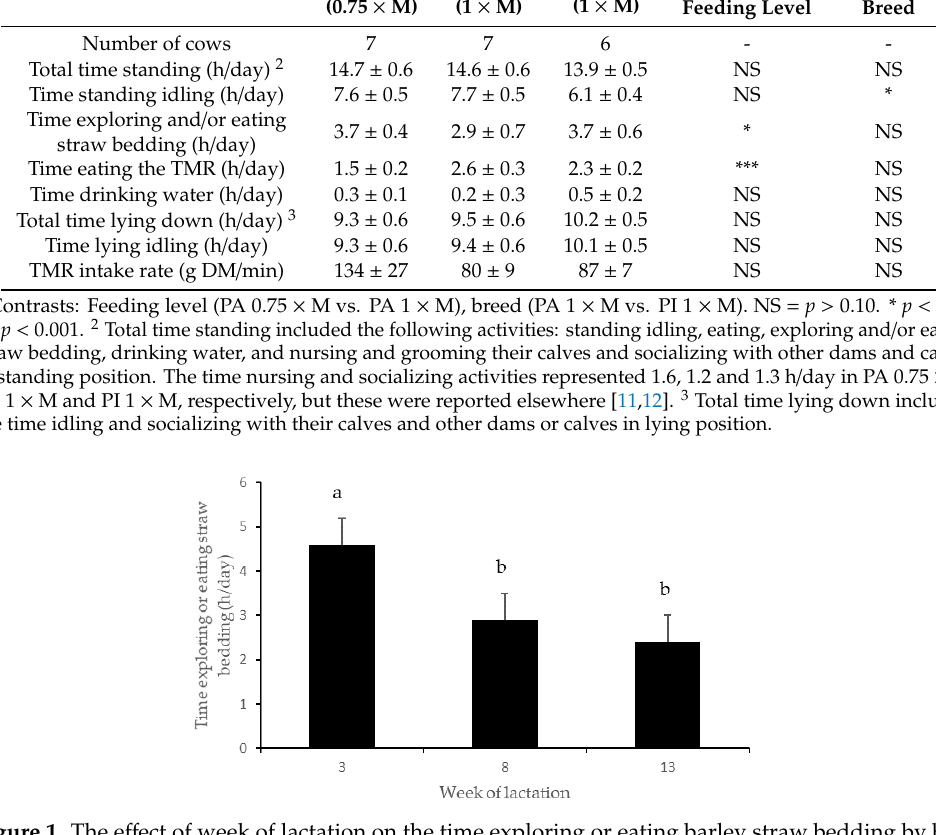
Figure 1. The effect of week of lactation on the time exploring or eating barley straw bedding by beef cows irrespective of breed (different letter between weeks denotes statistical differences, p < 0.05).